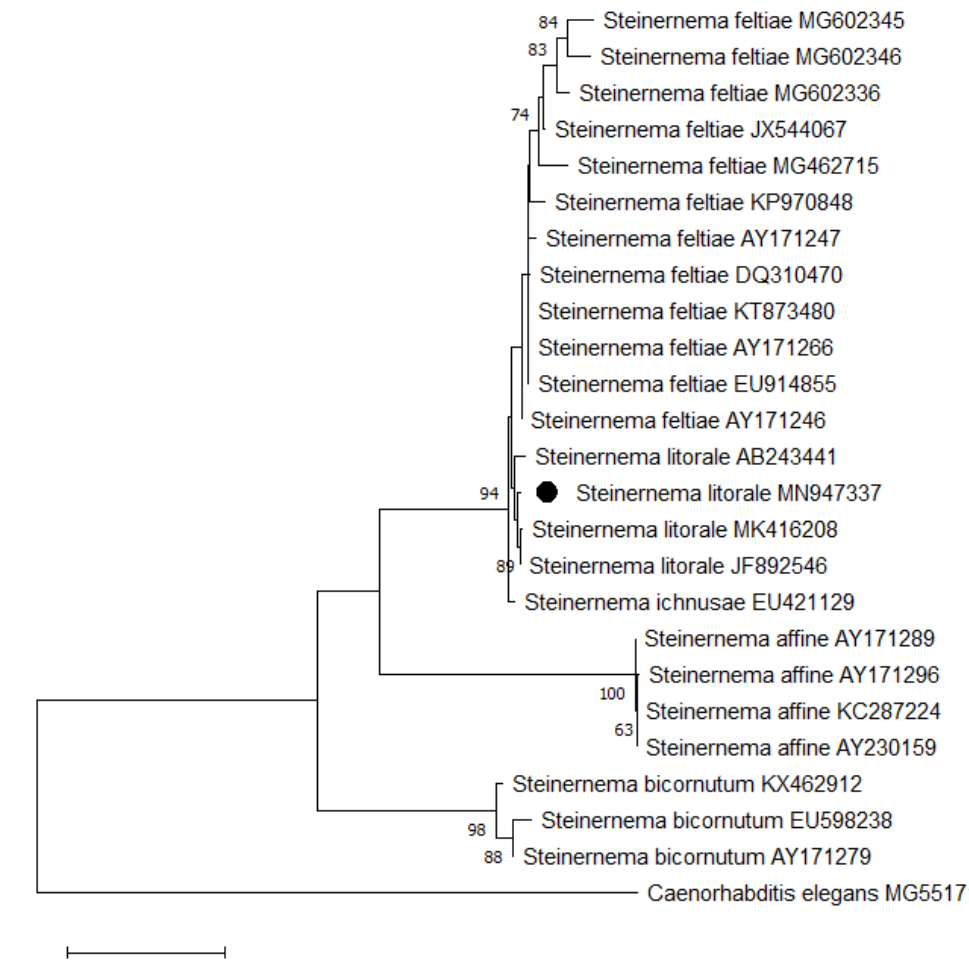
Figure 1. Phylogenetic relationships of the Steinernema species based on analysis of ITS rDNA regions. The tree was reconstructed by the maximum-likelihood method. Sequences of Caenorhabditis elegans (MG551717) was used as the outgroup species. The GenBank accession numbers are indicated after the name of the bacterial isolates. The number on the branches 60% indicates the percentage of 1000 bootstrap replicates. The bar represents 0.02 substitutions per site.